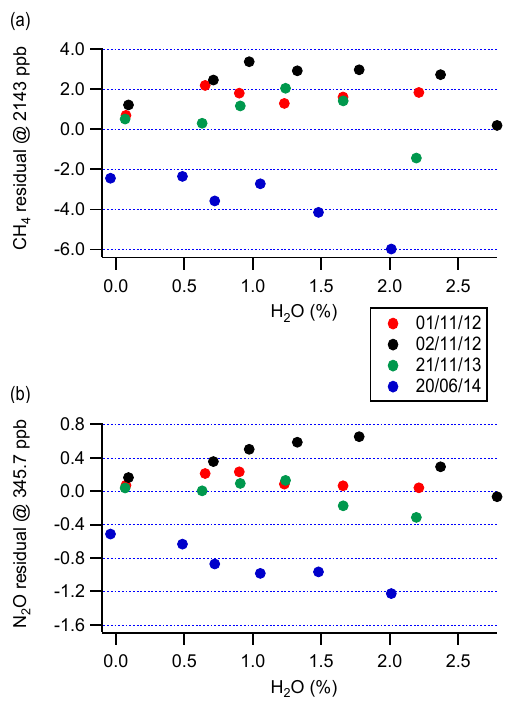
Figure 2. Residual error due to the influence of water vapour for the retrieval of (a) CH 4 and (b) N 2 O after applying an empirically derived scale factor to correct the data. Data from four identical experiments are shown; the residuals are calculated as the product of the fractional error for each measurement and the average mole fraction for the dry measurements taken during all four experiments.